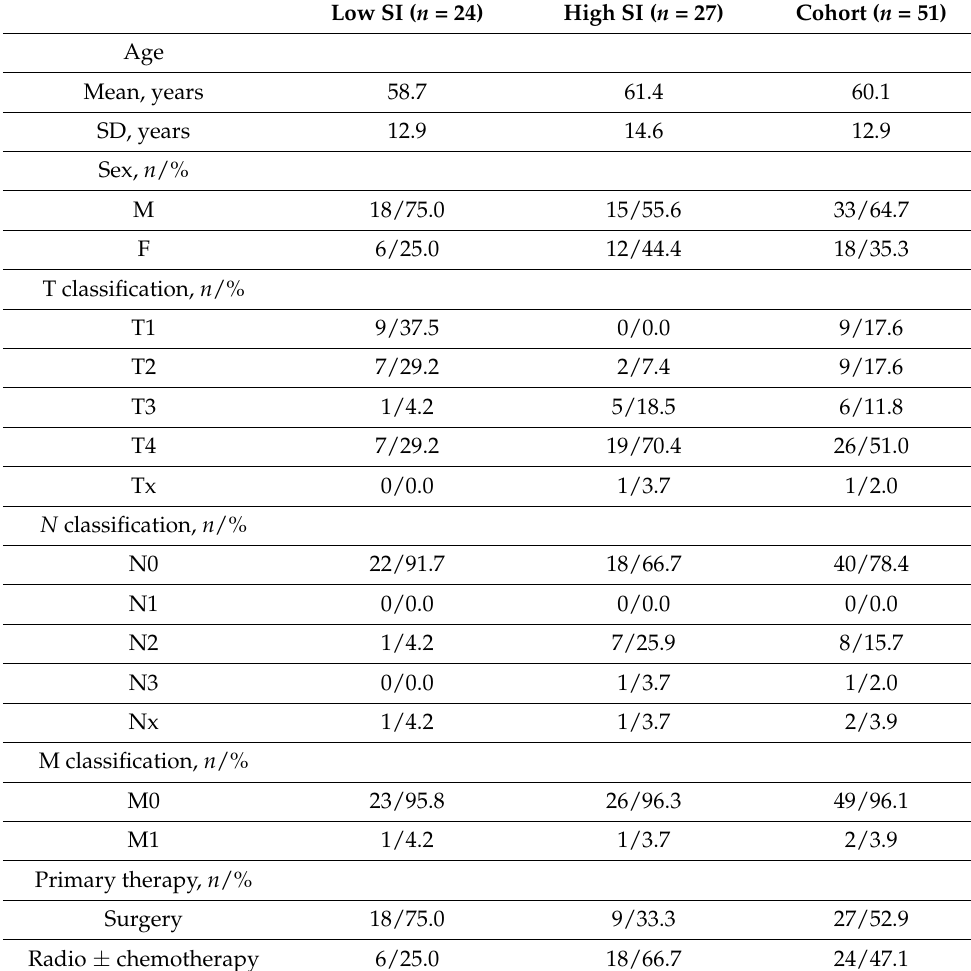
Table 2. Detailed tumor and patient characteristics stratified according to the pretreatment SI. SI; survival index, SD; standard deviation, M; male, F; female. Low SI ( n = 24) High SI ( n =